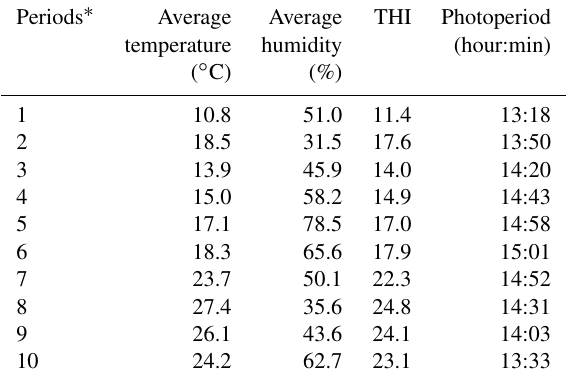
Table 2. Average climatic values, the temperature–humidity index (THI) and the length of the photoperiod during the experimental